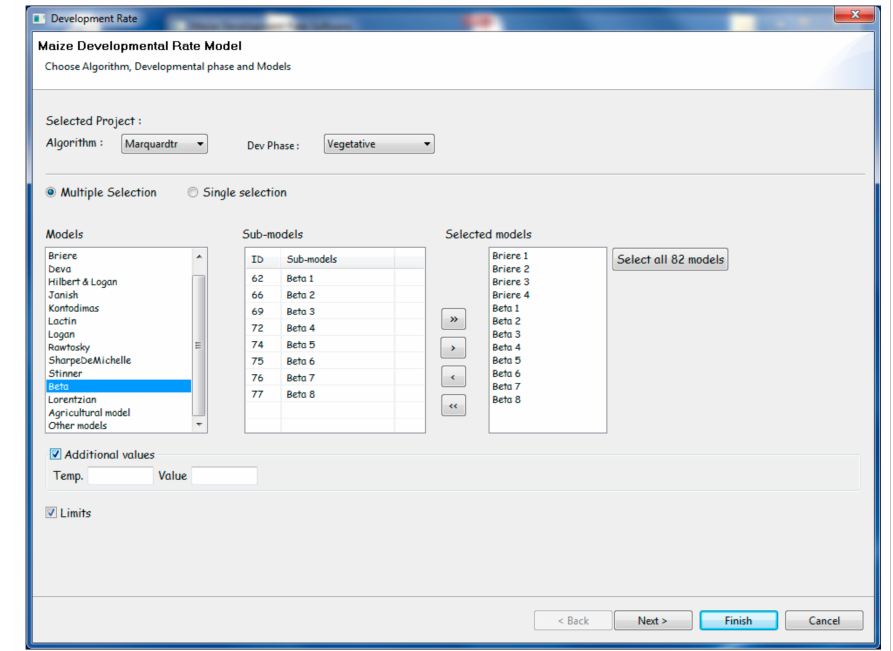
Figure 5. Illustrates the user interface of the “modeling component” of the PPMaP software. It shows the library of mathematical expressions that are used to describe the relationship between plant phase development and temperature. The left box contains the models characterized by the name of the author that pioneers the formulation. The center box contains the sub-models, which are derivative of the models from the left box. The right box contains the models selected for fitting. For example, in Briere i , the index i represents the number of the derived model from the original Briere